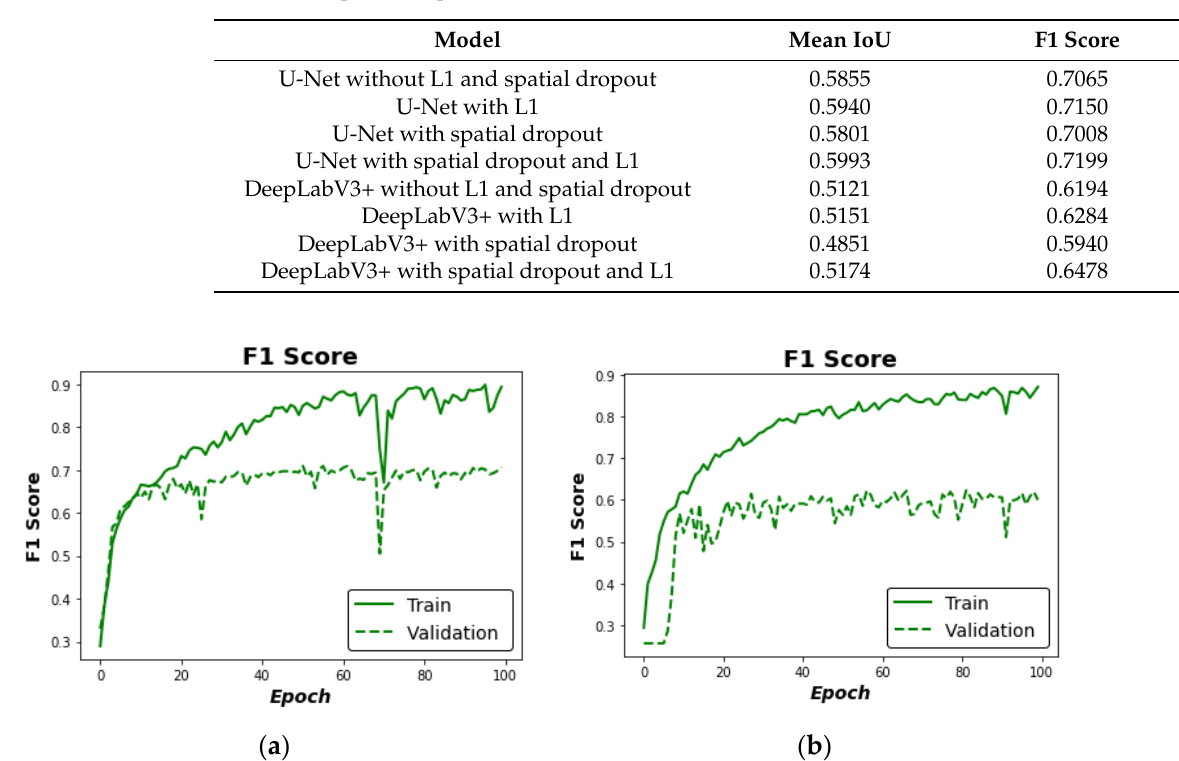
Table 3. U-Net and DeepLabV3+ trained using no regularization, L1 regularization, spatial dropout, and L1 and spatial dropout.